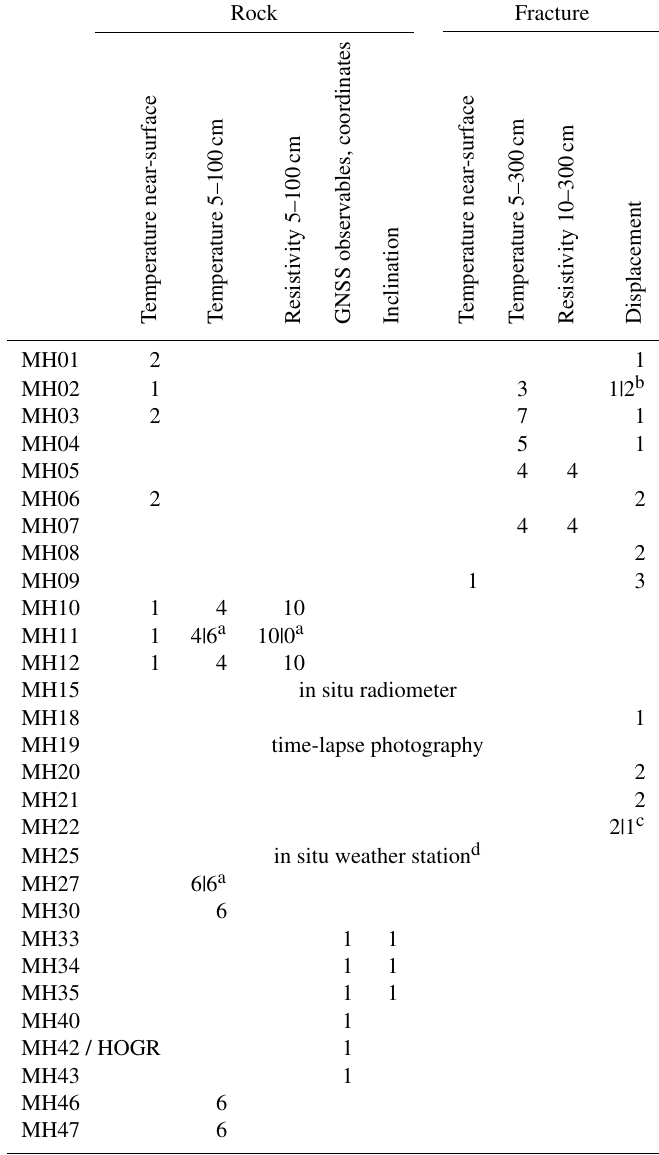
Table 2. Per position overview of sensor channels: for solid bedrock and fracture environments, the number of sensor channels are listed in this